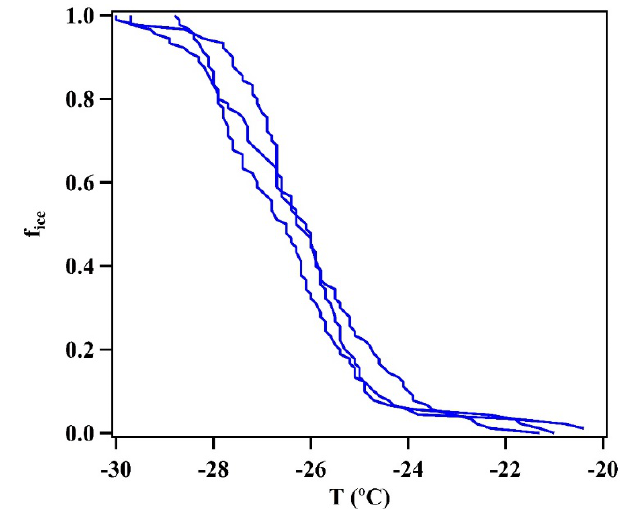
Figure A2. The temperature freezing dependency of distilled water droplets of 1 μL.